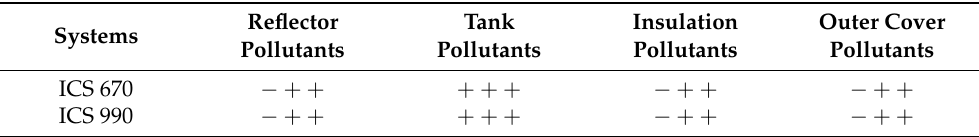
Table 4. Environmental impacts in fabrication and installation phases for the two selected, by the algorithm, best cases, following the description of the + and—rating sequence in Section 2.4.